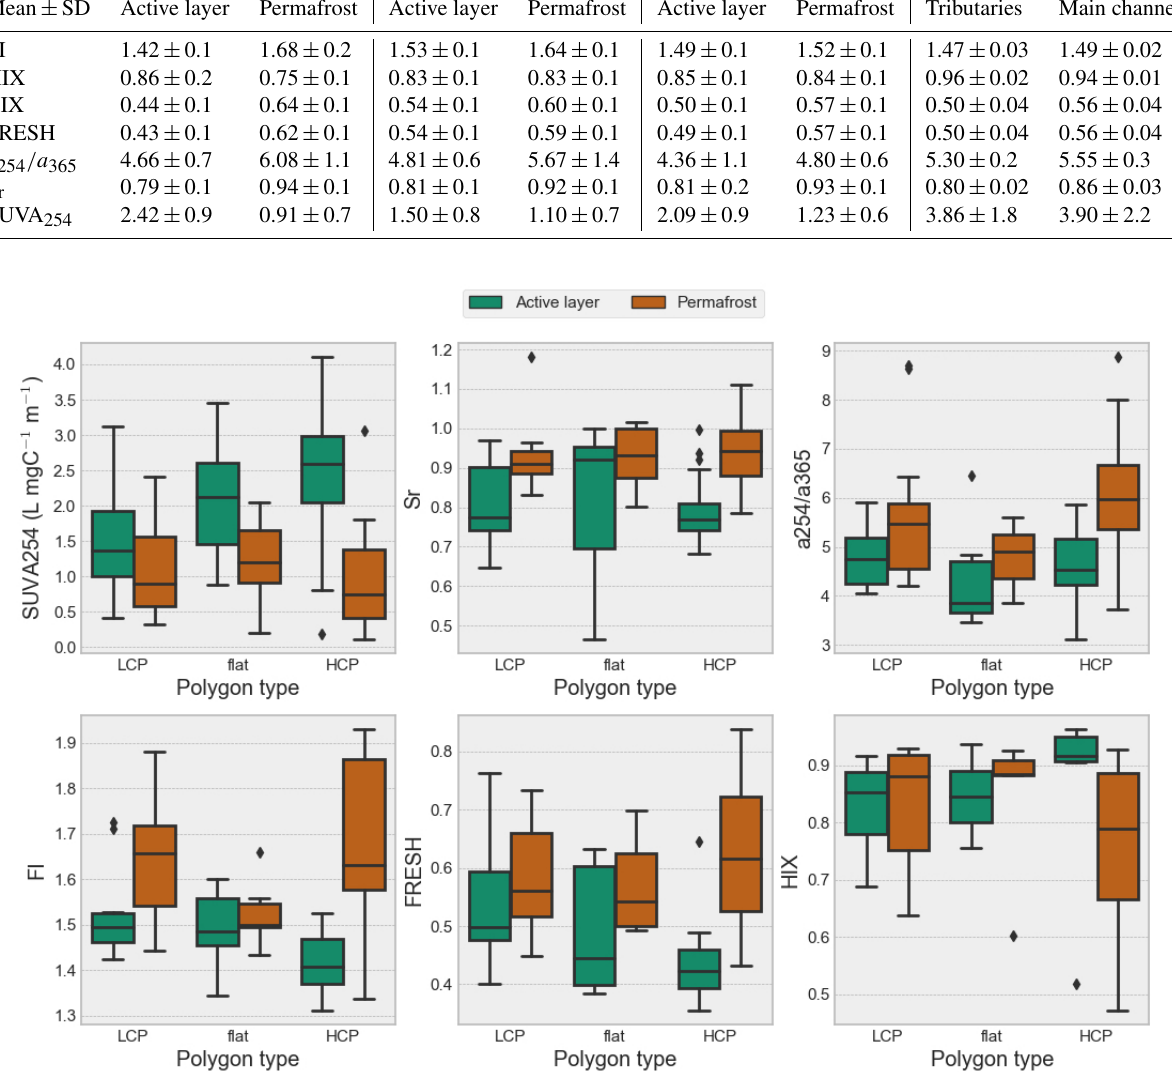
Figure 6. SUVA 254 , slope ratio ( S r ), absorbance ratio ( a 254 /a 365 ), fluorescence index (FI), freshness index (FRESH) and humification index (HIX) for both thermal layers in each polygon type. Differences between the two thermal layers are largest in HCPs and smallest in LCPs except for FI where the flat polygon type has the smallest difference between the active layer and permafrost, indicating a shift in biogeochemical processing of DOM as IWP degradation progresses (i.e., transition from LCPs to